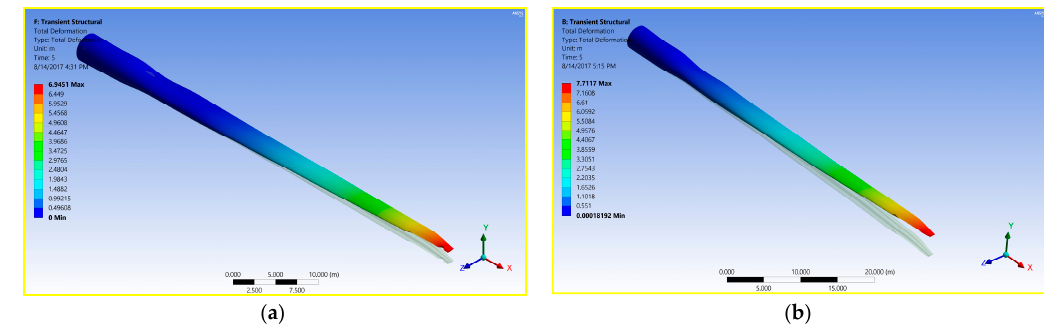
Figure 17. Total blade deformation; ( a) uni-directional, and ( b )bi-directional, at the end of 5 s